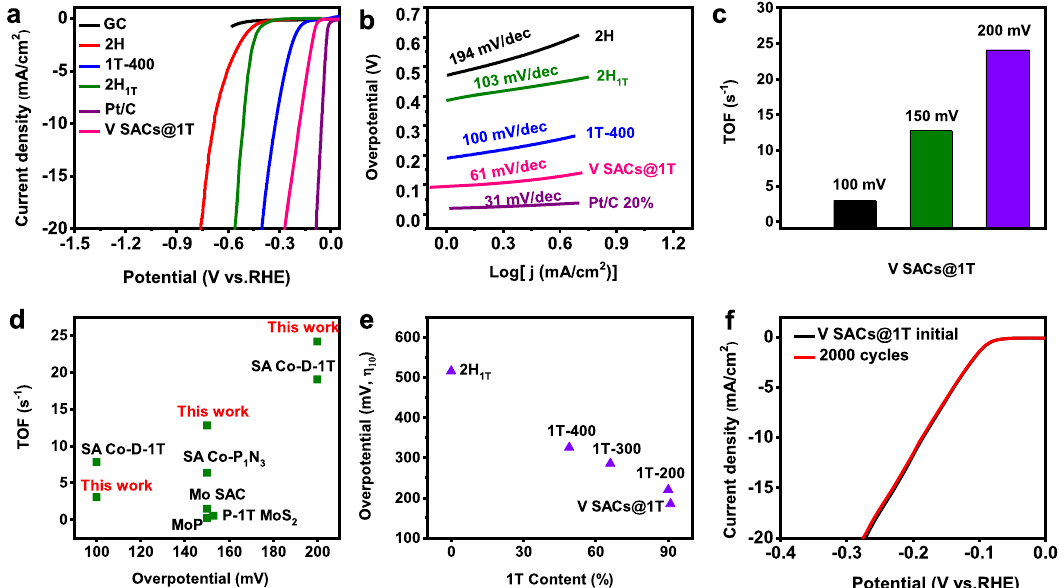
Fig. 5 HER performance of V SACs@1T-WS 2 . a LSV curves of GC, 2H (2H-WS 2 ), 1T-400 (V SACs@1T-WS 2 annealed at 400 °C in H 2 /Ar for 2 h), 2H 1T (V SACs@2H-WS 2 , transformed by V SACs@1T-WS 2 ), Pt/C (Pt/C 20%) and V SACs@1T-WS 2 electrodes in 0.5 M H 2 SO 4 with a scan rate of 5 mV/s. b Tafel plots of 2H, 1T-400, 2H 1T , Pt/C 20% and V SACs@1T electrodes. c TOF values of V SACs@1T-WS 2 measured at different overpotentials. d TOF comparison with other representative electrocatalysts. e HER activity as a function of the 1T phase ratios obtained by annealing V SACs@1T-WS 2 in the H 2 /Ar for 2 h. f Electrochemical stability of V SACs@1T-WS 2 after 2000 cycles of CV